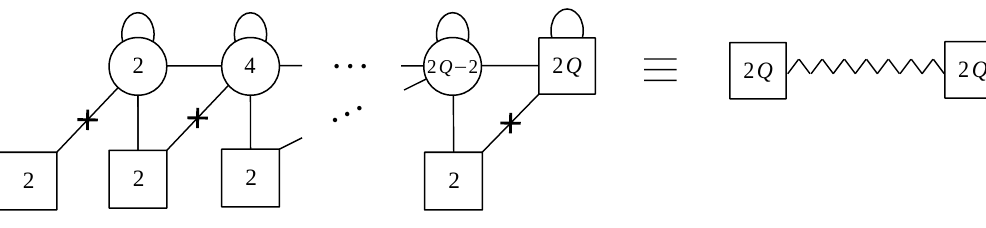
Figure 1: The E [ USp ( 2 Q )] quiver theory. Each gauge node has USp ( 2 n ) symmetry, while each flavor node carries SU ( 2 ) symmetry. The crosses indicate singlets flipping the diagonal mesons. The lines starting and ending on the same node stand for two- index antisymmetric field which for the USp ( 2 Q ) flavor node is also traceless. The IR global symmetry group is USp ( 2 Q ) × USp ( 2 Q ) × U ( 1 ) 2 . On the rhs we introduce a compact representation of the IR SCFT to which E [ USp ( 2 Q )] flows to.